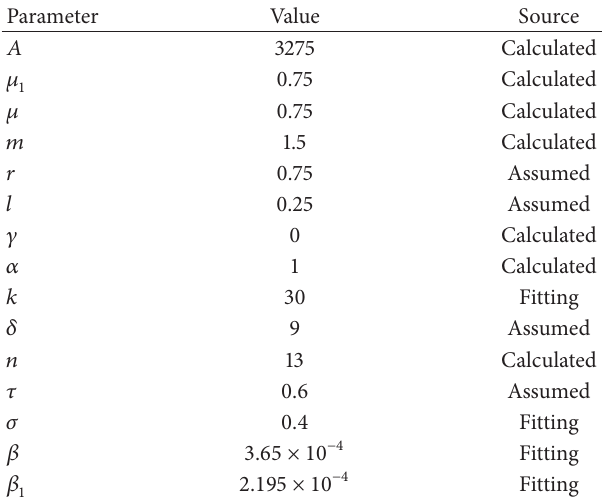
Table 2: Parameter values of system (1) (Unit Quarter − 1